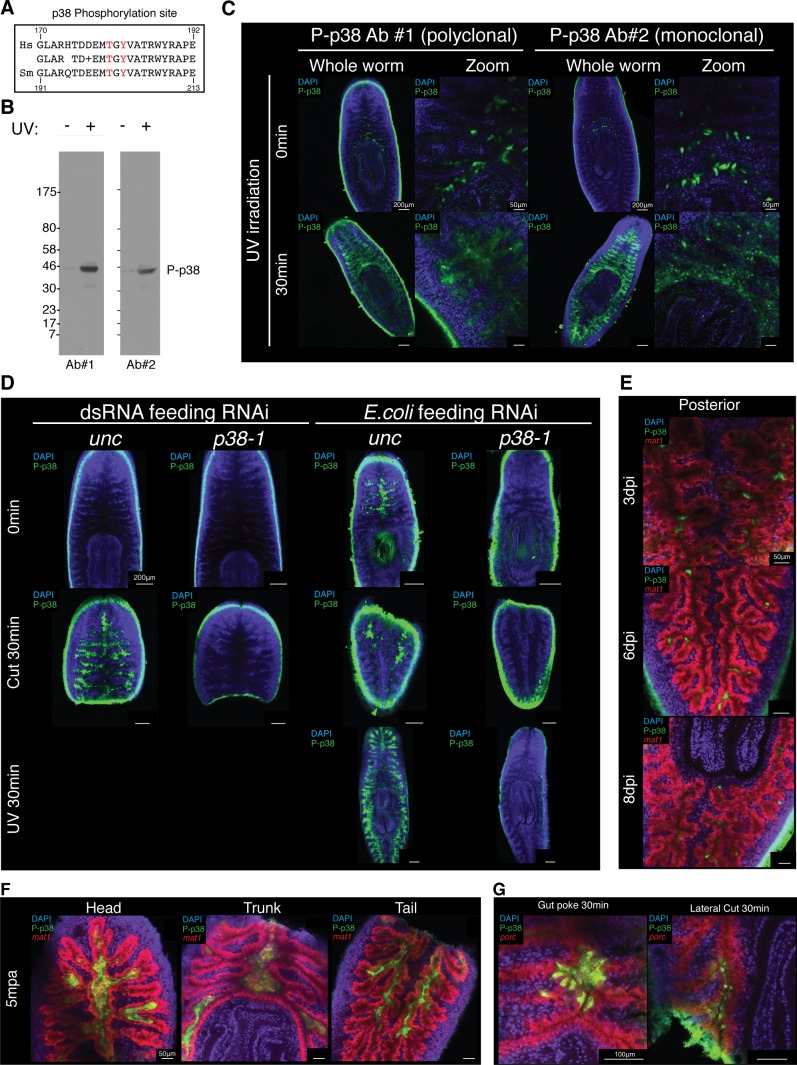
Validation of an antibody that recognizes planarian P-p38.(A) Conservation of the amino acids surrounding the Thr180/Tyr182 p38 phosphorylation in Homo sapiens and Schmidtea mediterranea. (B) Western blot of planarian protein lysate that is untreated or treated with 30 min of UV irradiation and stained with P-p38 antibody #1 (polyclonal) or P-p38 antibody #2 (monoclonal). (C) Whole mount P-p38 antibody of staining of planaria that are untreated or treated with 30 min of UV irradiation (n > 4 worms). (D) Whole mount P-p38 antibody staining of planaria following unc or p38-1 RNAi and subjected to the following treatments: untreated, 30 min post amputation, 30 min post UV irradiation (n > 3 worms). Confocal images of (E) infected posterior gut or (F) amputated fragments following WISH of the gut marker mat1 and anti-P-38 staining. (H) Whole mount ISH of porc and P-p38 staining of gut tissue injured via poking or lateral cut (n > 2 worms).